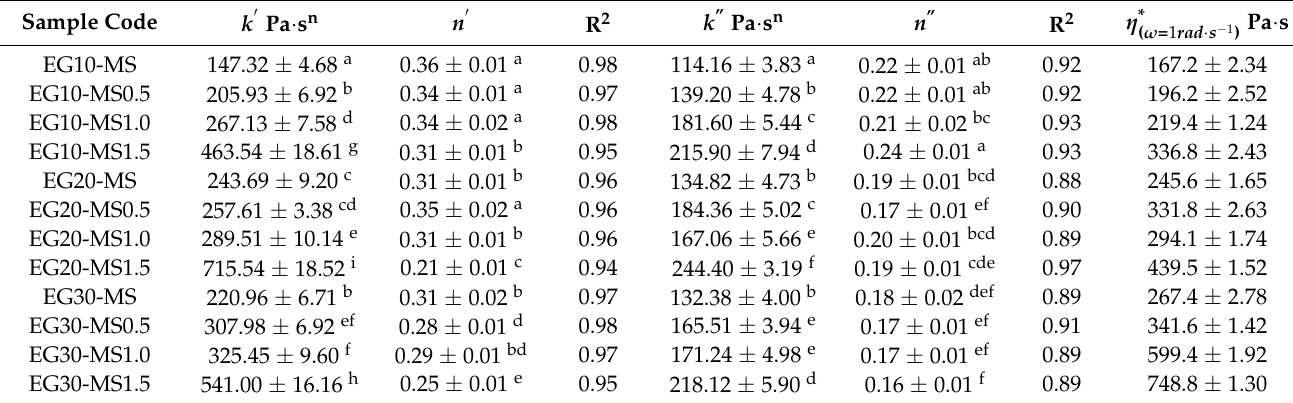
Table 3. Viscoelasticity parameters for carboxymethyl cellulose/mango-starch emulsion gels with 1% w/w of mango peel extracts. Sample